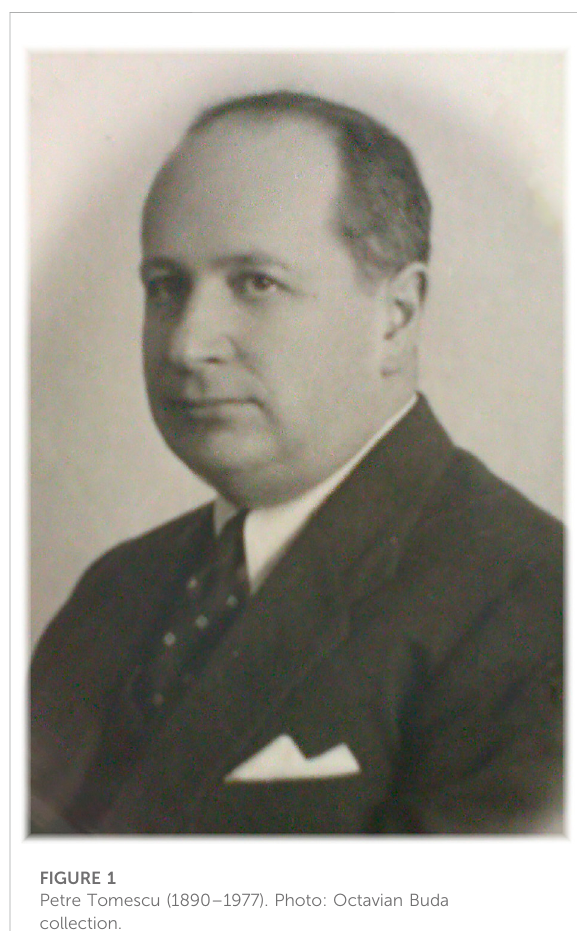
FIGURE 1 Petre Tomescu (1890 – 1977). Photo: Octavian Buda